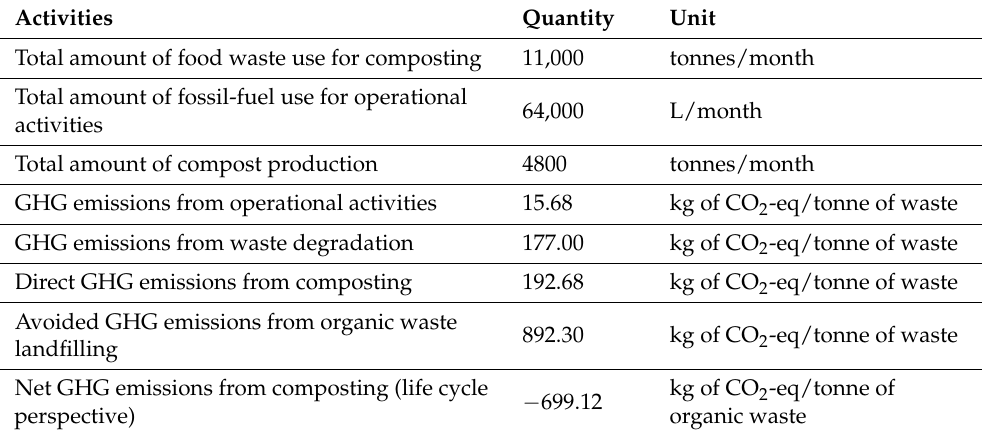
Table 4. GHG emission estimates from composting activities in Ho Chi Minh City (data source: DONRE , 2012